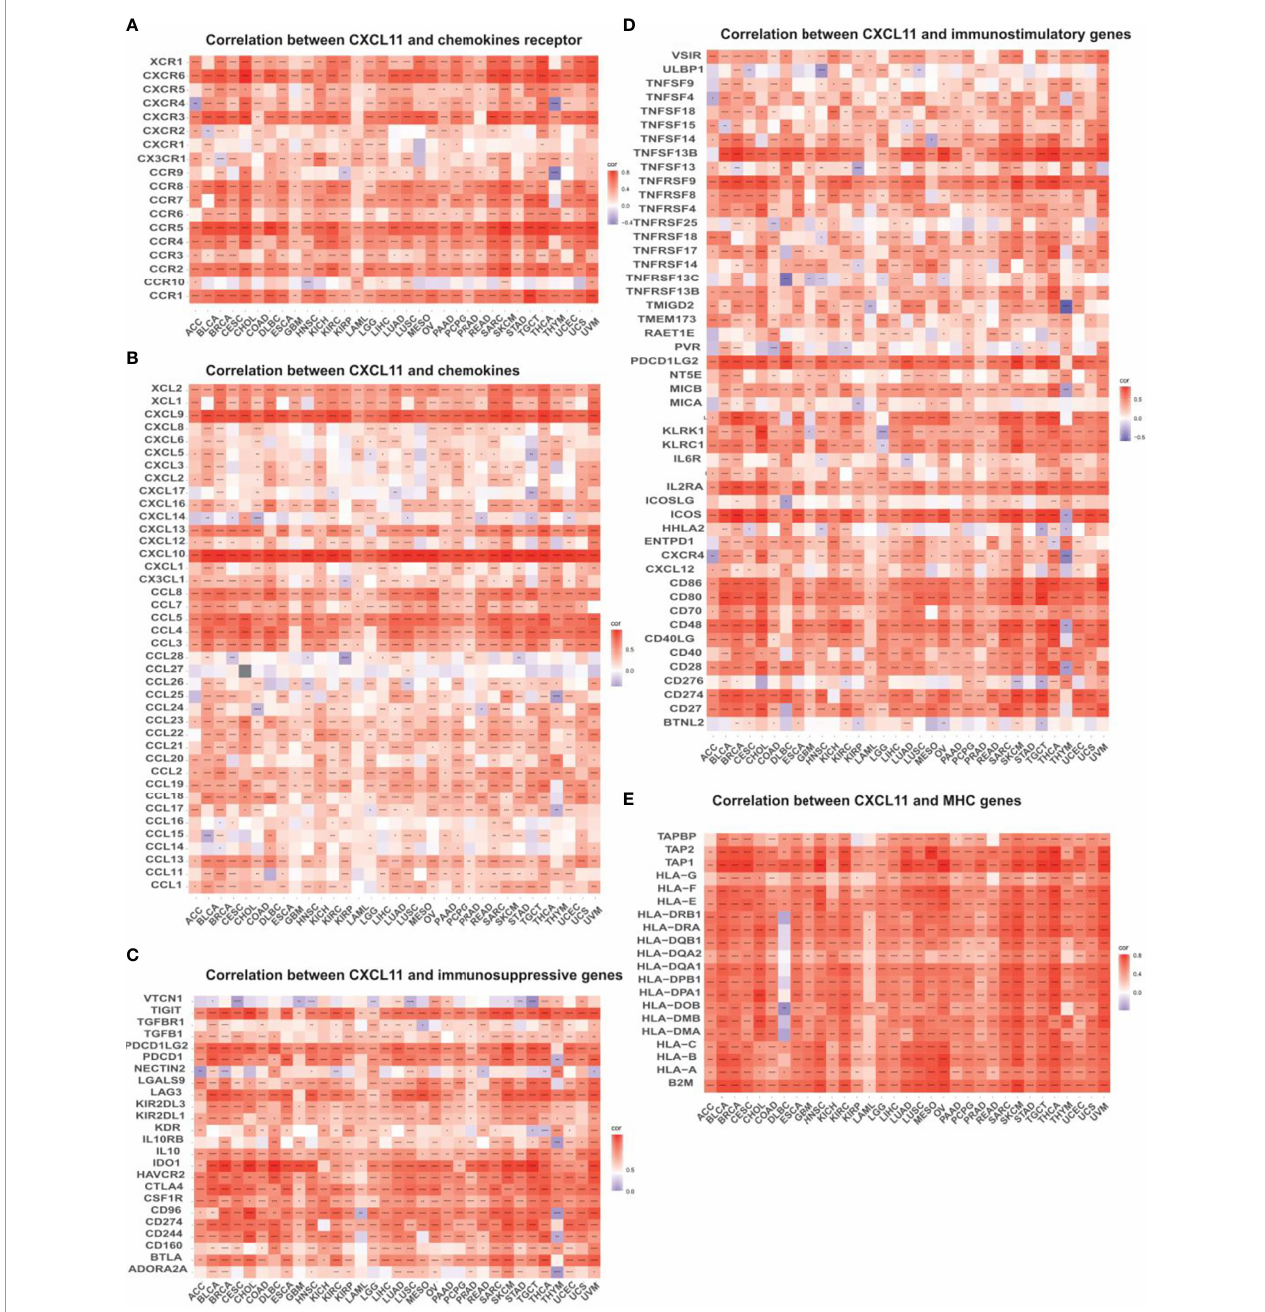
FIGURE 11 | Relationship between CXCL11 and (A) chemokine receptors, (B) chemokines, (C) immunosuppressive factors, (D) immunostimulatory factors, and (E) MHC genes. *p < 0.05, **p < 0.01, ***p < 0.001, ****p <